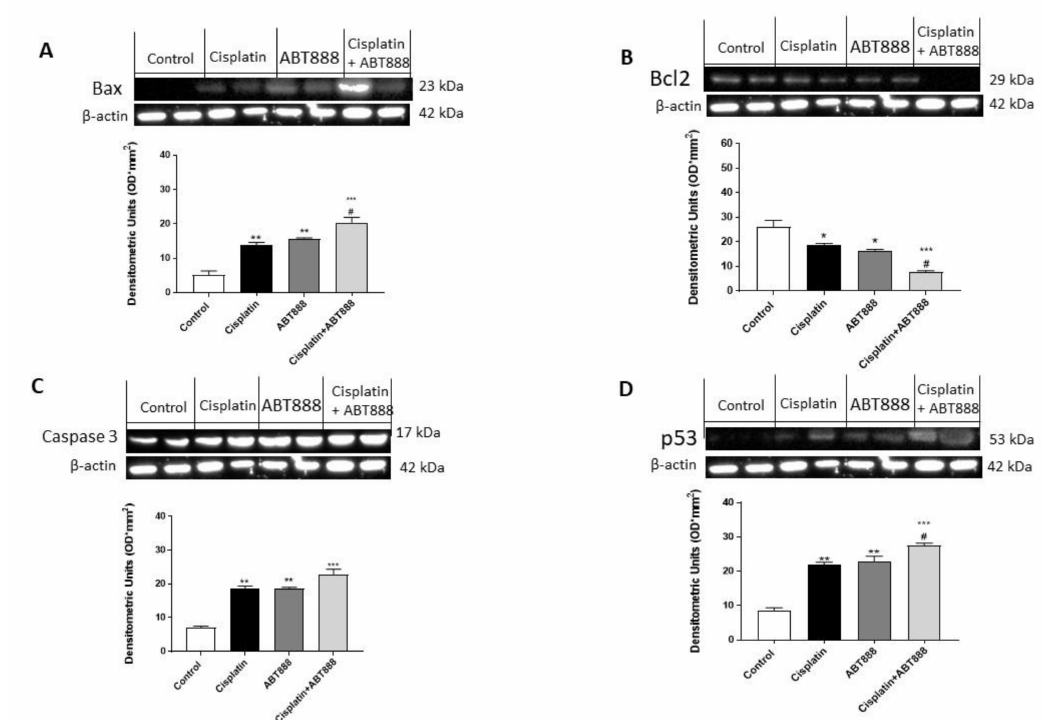
Figure 5. Effect of ABT888 and cisplatin on apoptosis pathway in Ca9-22 cell line. The blots revealed an increase in Bax, caspase-3 and p53 expression in the group with the combinatory treatment of ABT888 and cisplatin (Figures A, C and D, respectively) compared to the single treatments and control group, whereas Bcl2 expression was significantly reduced in the combinatory treatment of ABT888 and cisplatin, compared to control group (Figure B). ( A ) ** p < 0.01, *** p < 0.001 vs. the control; # p < 0.05 vs. cisplatin group. ( B ) * p < 0.05, *** p < 0.001 vs. the control; # p < 0.05 vs. cisplatin group. ( C ) ** p < 0.01, *** p < 0.001 vs. the control. ( D ) ** p < 0.01, *** p < 0.001 vs. the control; # p < 0.05 vs. cisplatin